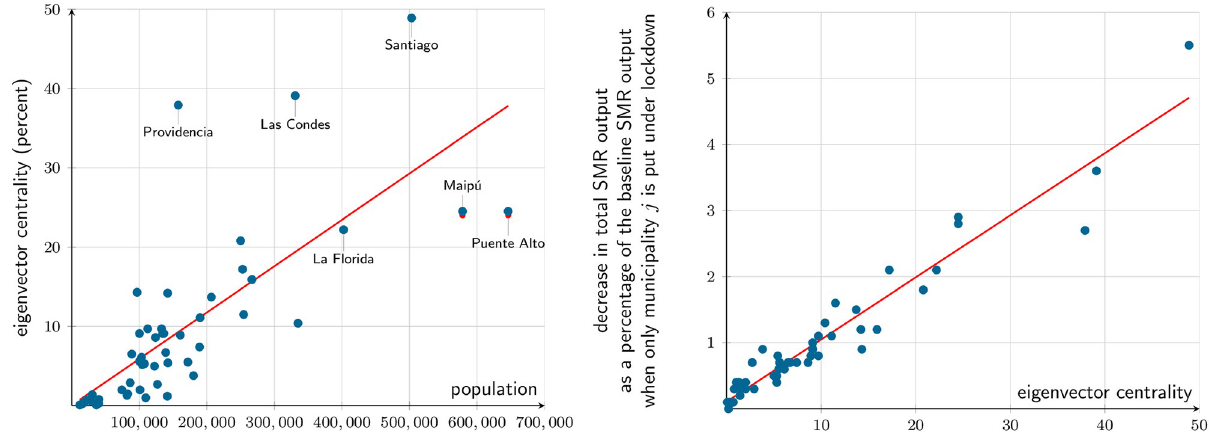
Fig 4. Eigenvector (commuting) centrality. (a) Eigenvector centrality vs. population. (b) Eigenvector centrality vs. municipal marginal output. Source: authors’ computations. Eigenvector centrality is computed from the commuting origin-destination matrix obtained from ENE [40], December 2019 (i.e., under no lockdown). Population, from 2020 projections